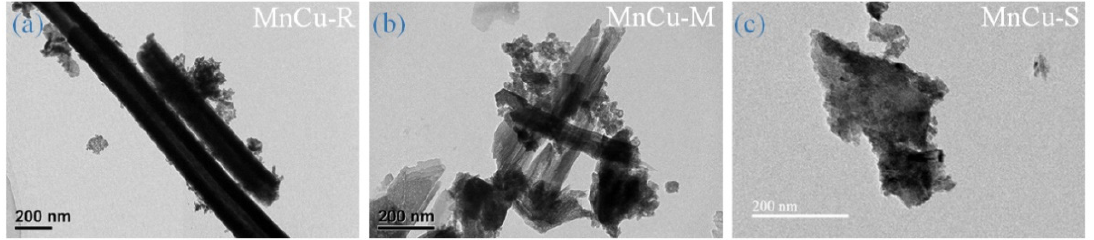
Figure 6. FETEM images of ( a ) MnCu-R, ( b ) MnCu-M, and ( c )